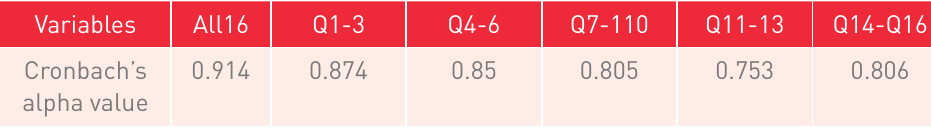
Reliability test